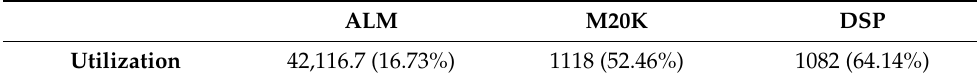
Table 2. FPGA resource utilization.